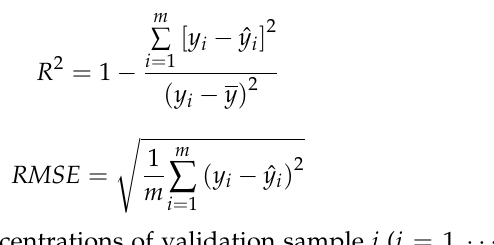
where y i is the measured concentrations of validation sample i ( i = 1, · · · , m ), m is the number of validation samples, y is the mean of y i , and ˆ y i is the predicted